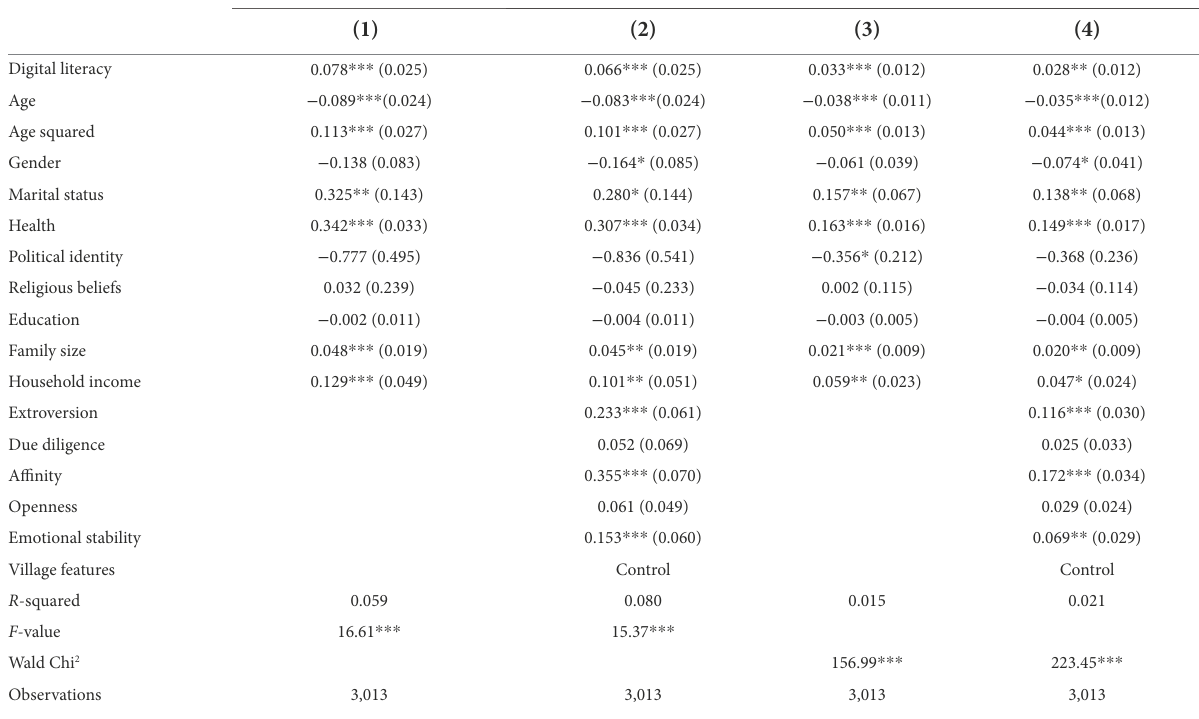
TABLE 2 Estimated results of the effect of digital literacy on the happiness of rural low-income